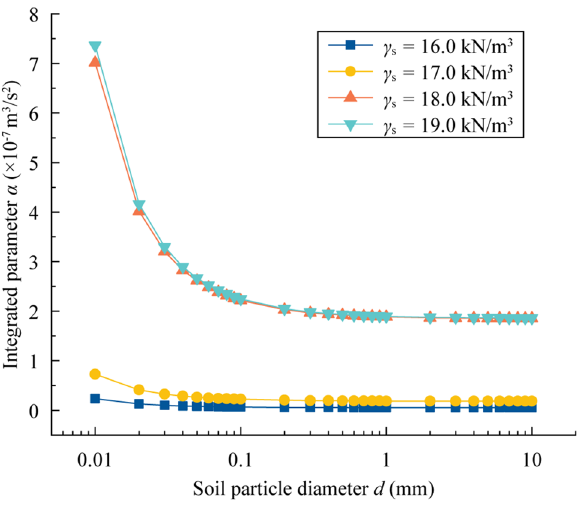
Figure 9. Integrated parameter of bonding force α varying with the soil unit weight and soil particle